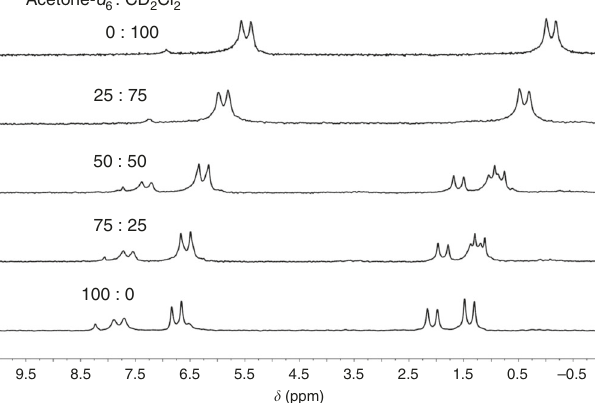
Fig. 5 Partial 31 P{ 1 H} NMR spectra (121 MHz, 298 K). a 31 P{ 1 H} NMR spectra of 10 in acetone- d 6 in the absence and presence of NaOTf and 18C6. b 31 P{ 1 H} NMR spectra of 10 in a mixing solvent of acetone- d 6 / CD 2 Cl 2 (v/v). The concentrations are 15 mM for bis-matallacage 9